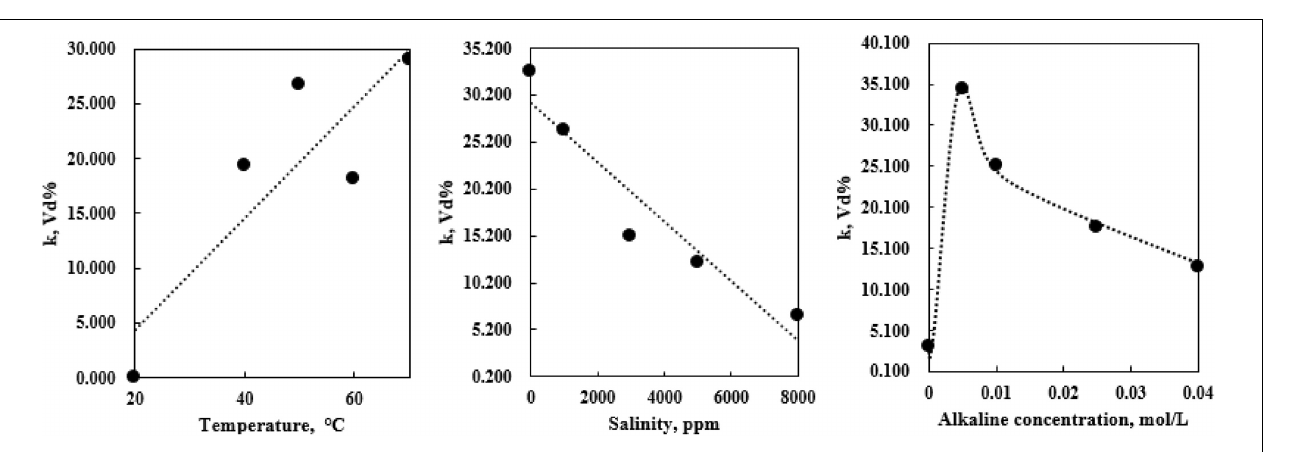
As Table 5 shows, the most important factor that affects the total phase dispersion for NaOH bottle test is temperature, with the range of 26.745%. The other two factor ranges are